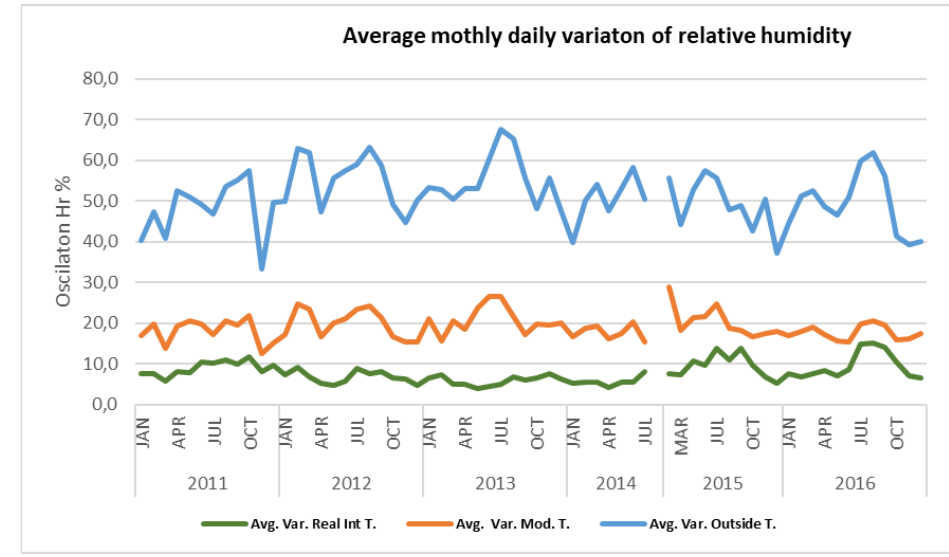
Figure 22. Variation of the average monthly daily humidity for the period 2011 – 2016.